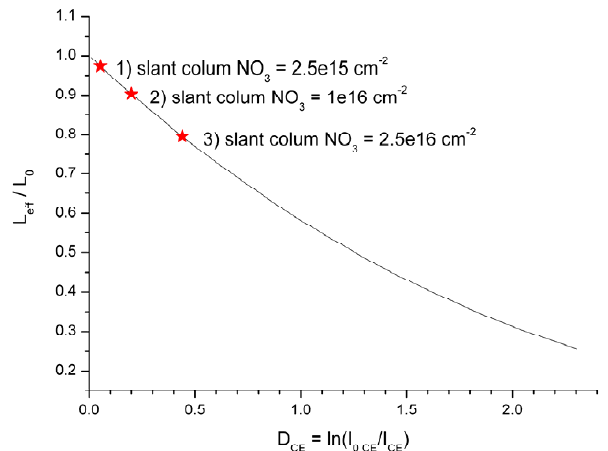
Fig. 3. Reduction of the light path L eff in a cavity due to extinction in the cavity (expressed as optical density D CE ). Plotted is the ratio L eff /L 0 , where L 0 denotes the average light path in an empty (air filled) cavity as described in the text. For illustration the effective light paths at 662nm (peak of the NO 3 absorption band) for three realistic NO 3 total column densities (in cm -2 ) in the cavity are also shown [see Meinen et al. 2009].